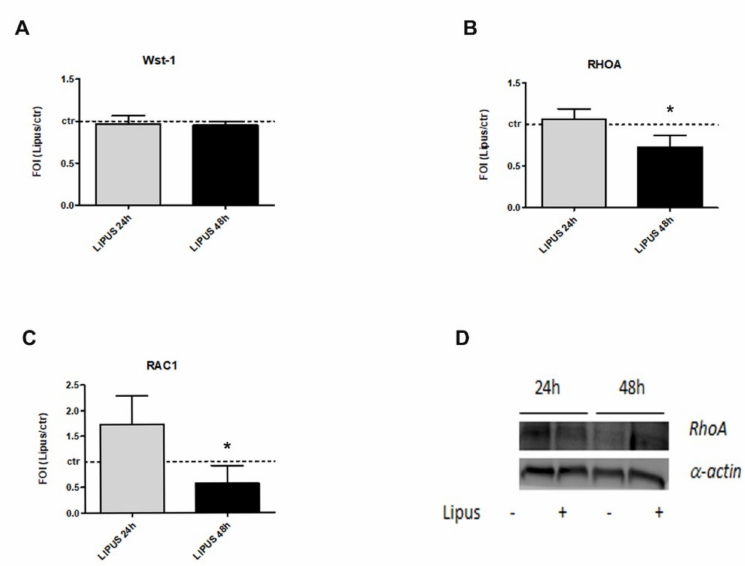
Figure 1. Effects of low-intensity pulsed ultrasound (LIPUS) stimulation on cytoskeletal proteins modulation in terms of cell viability ( A ), expression of RhoA ( B ) and Ras-related C3 botulinum toxin substrate 1 (RAC1) ( C ) genes, and synthesis of RhoA protein ( D ). Human MSCs stimulated with LIPUS for 24 h and 48 h showed no differences in cell viability by WST1 assay compared to LIPUS and the untreated group. Quantitative RT-PCR data are expressed as fold of change (FOI) in gene expression (2 − ∆∆ C t ) and occurred in LIPUS respect to untreated groups. RhoA and α -actin protein modulations were evaluated by western blot analysis ( D ). Student’s t test: *, p < 0.05 between experimental time.